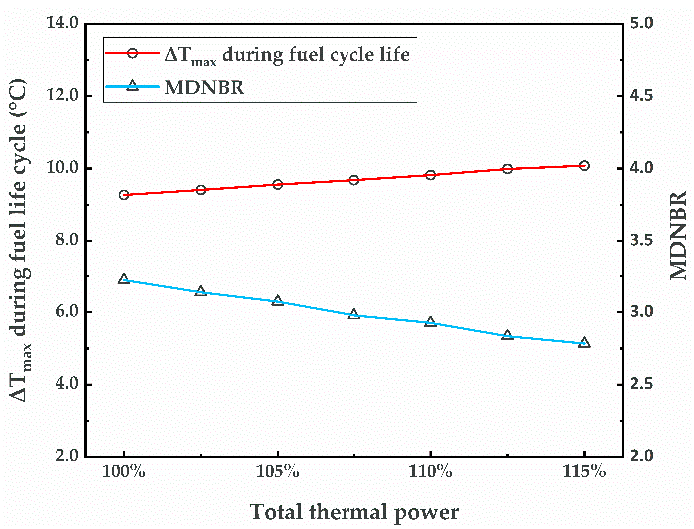
Figure 6. Optimization results under different total thermal powers.